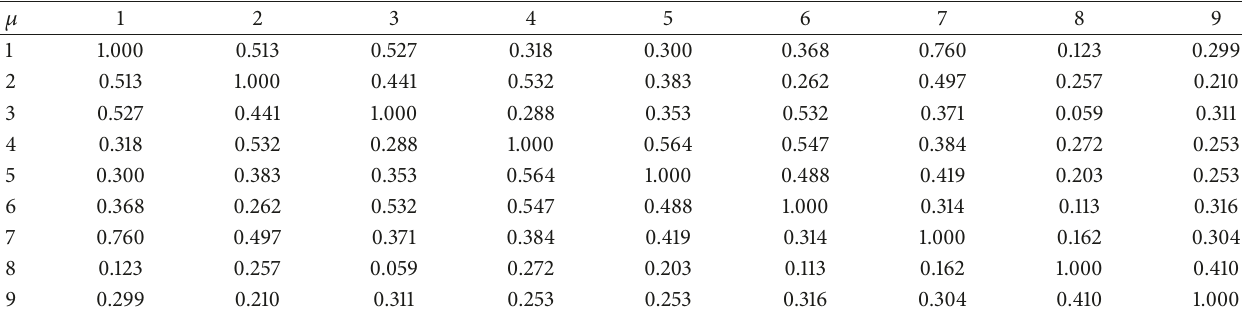
Table 11: Membership parts of the intuitionistic fuzzy pairs, giving the intercriteria correlations of glass.